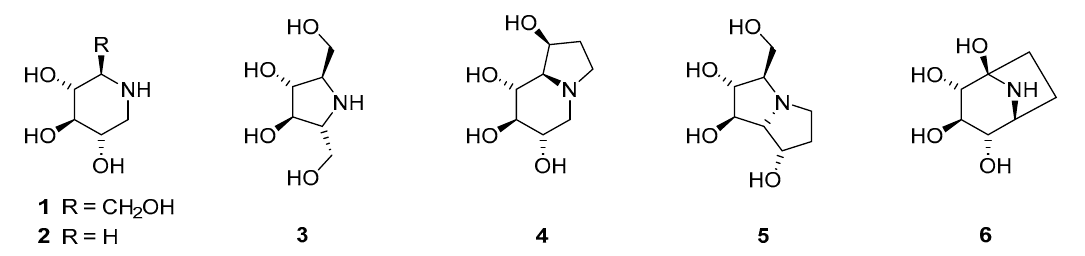
Figure 1. Paradigmatic structural examples of selected iminosugars 1 – 6 .